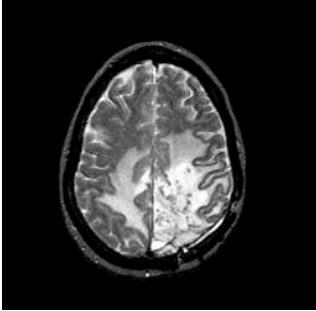
Figure 3. Host Image. Figure 4. Host